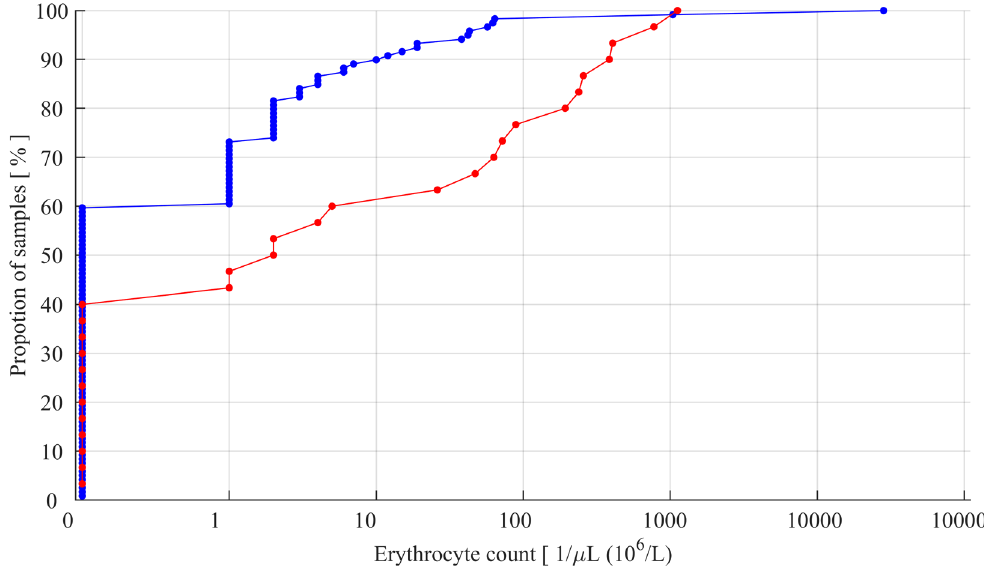
Figure 1. Cumulative distribution curves of erythrocyte count data obtained from the study LP procedures that were successful at the first attempt (blue line) and not successful at the first attempt (red